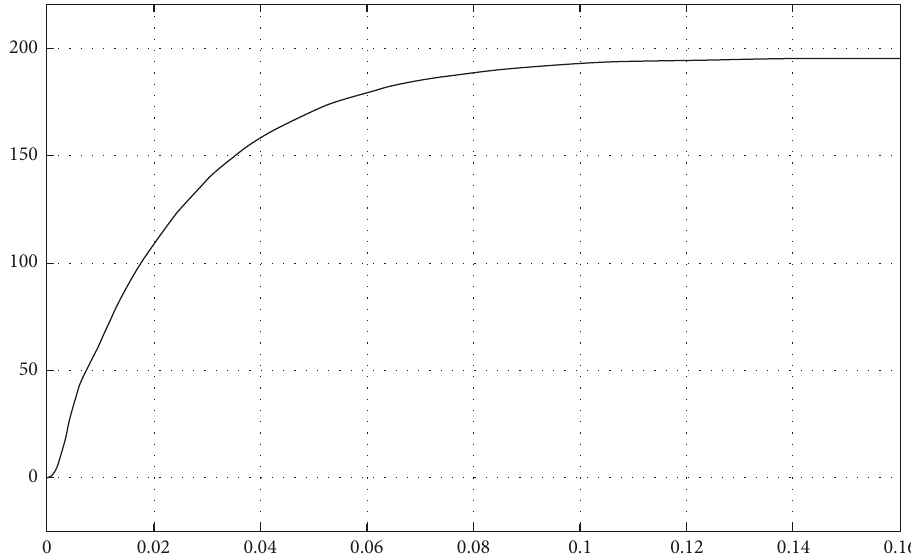
Figure 12: Output current waveform of when the conduction angle of H-bridge is 0.